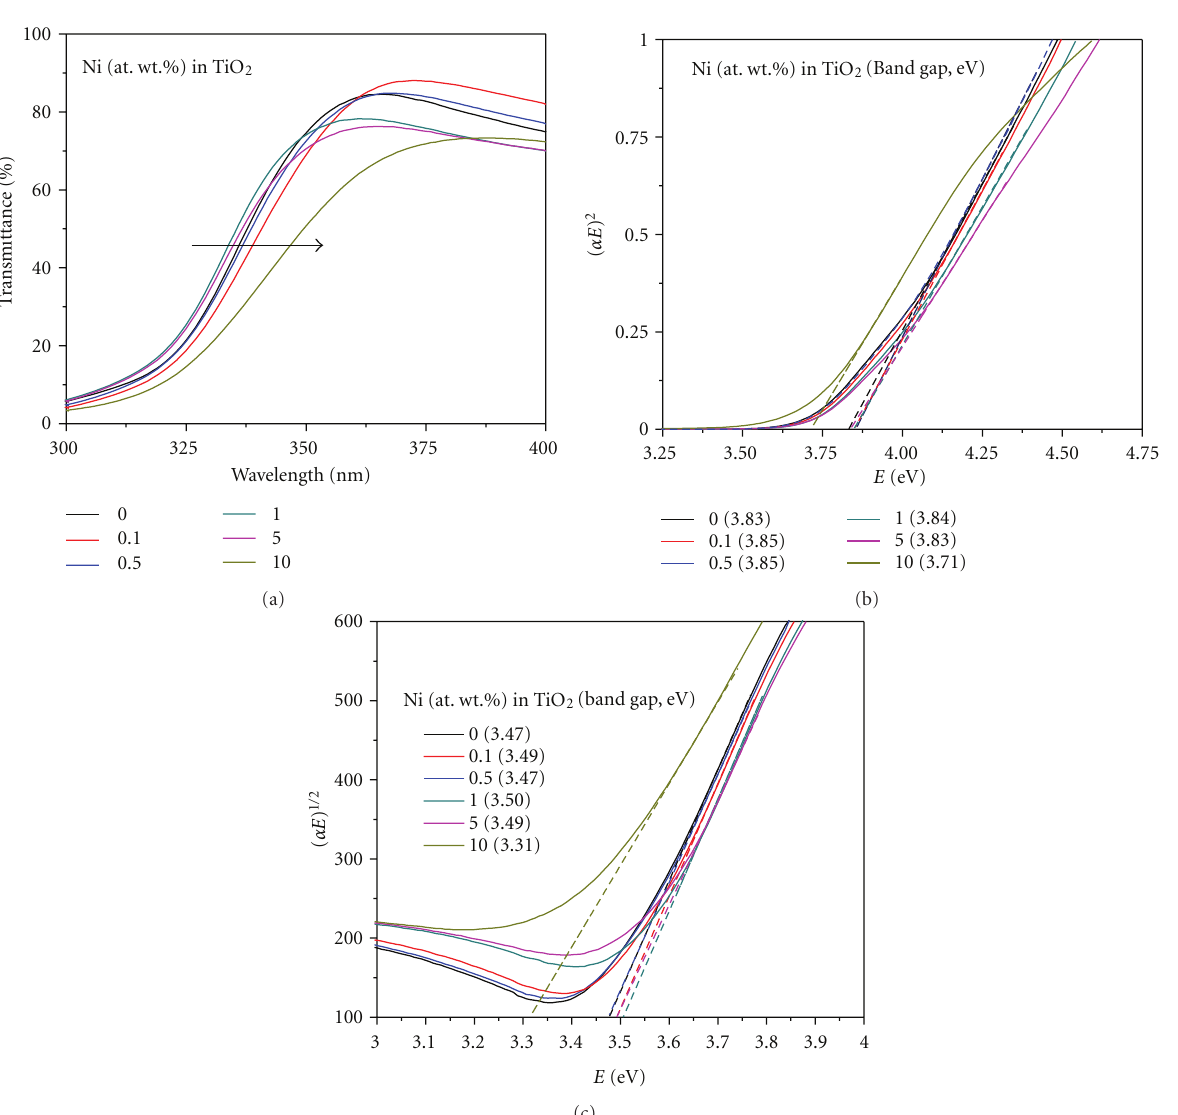
number of incident photons, is evaluated at 350 nm by the means of